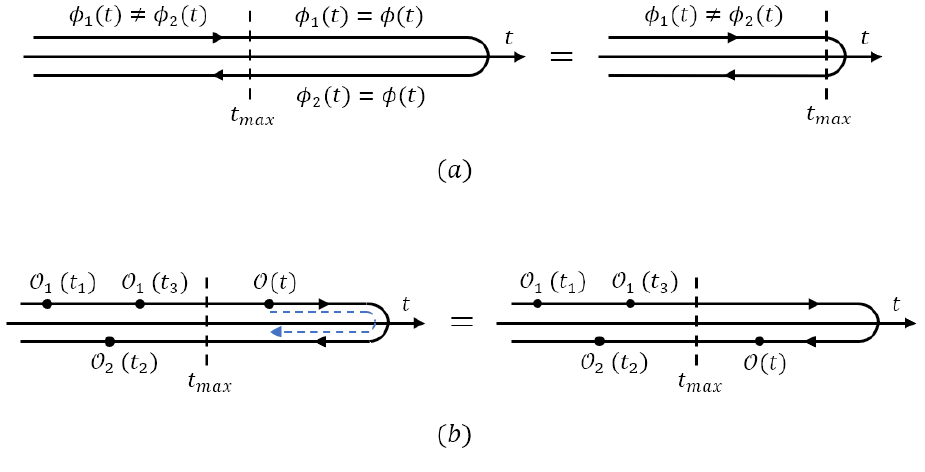
Figure 1 . Largest time equation. (a) From the perspective of external sources: the path integral is independent of the part where the external sources for upper and lower contours are the same; (b) From the perspective operator insertion: for the operator with the largest time it does not matter whether one inserts it on the upper or lower